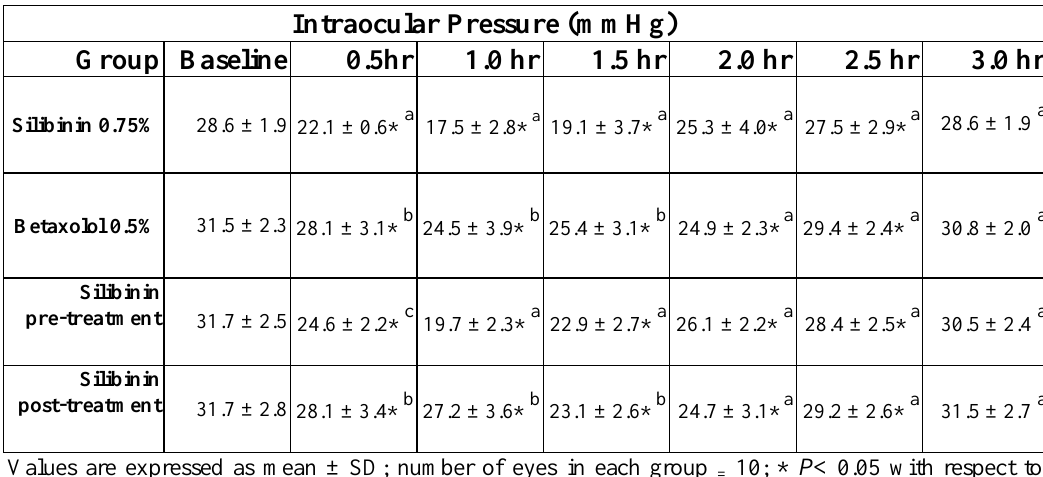
Table 1. Effects of instillation of silibinin 0.75% and betaxolol 0.5% on the intraocular pressure (IOP) in normotensive rabbits.